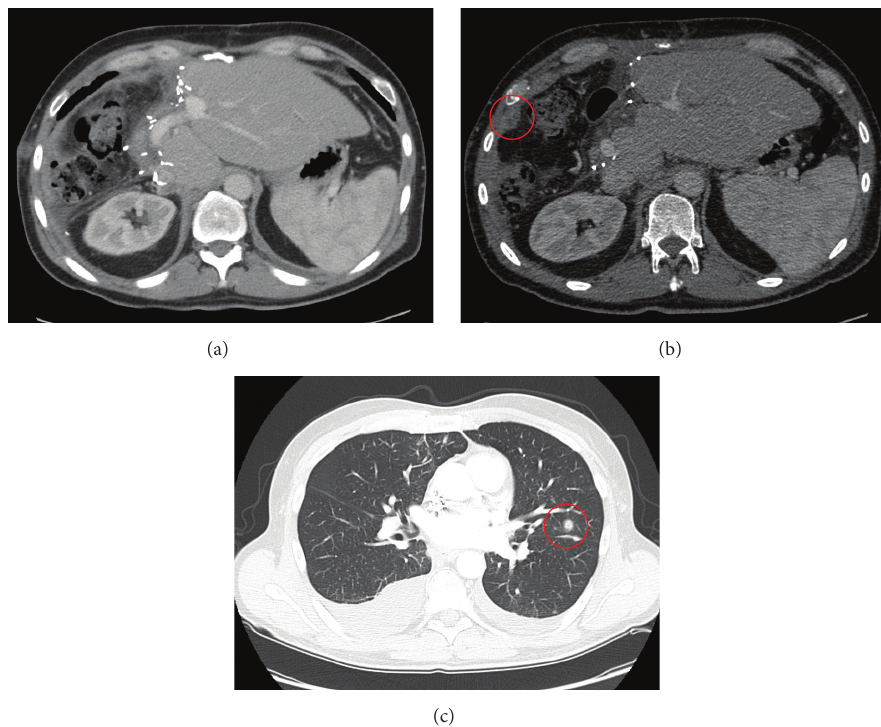
Figure 3: Follow-up CT-scan. Follow-up CT-scan approximately 2.5 months after liver resection showing the further volume increase of the liver remnant (a). Furthermore, examples of the novel extrahepatic tumor manifestations in terms of peritoneal carcinosis (b) as well as lung metastases (c) are shown (marked by red circles,